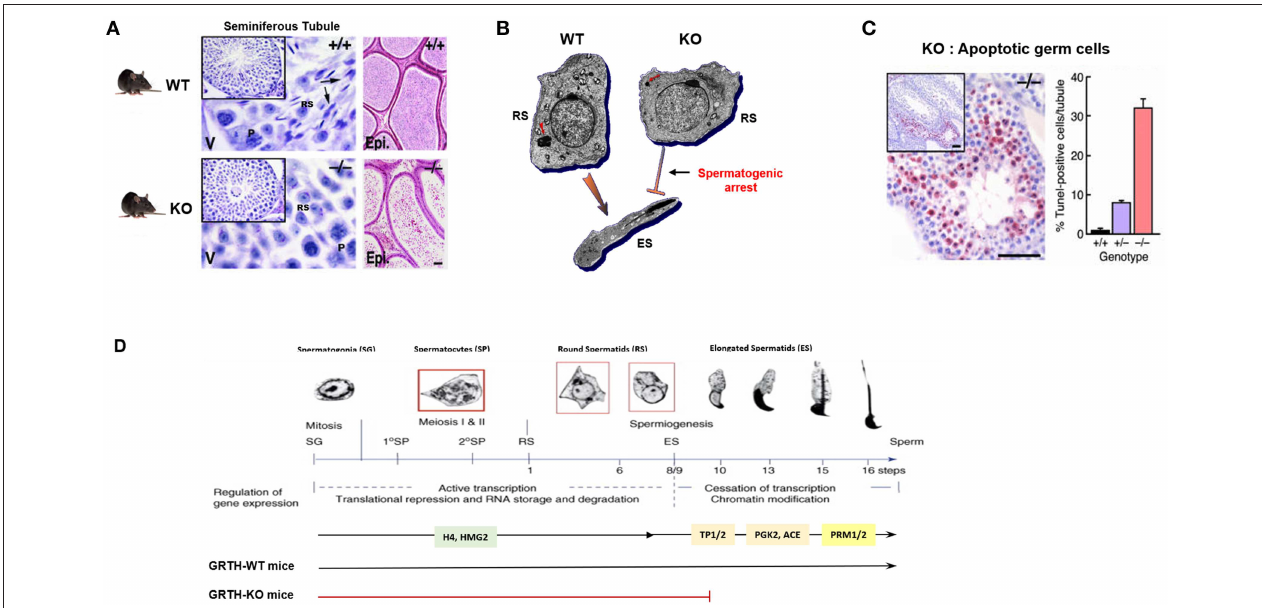
FIGURE 3 | GRTH-KO mice model reveal the role of GRTH in the completion of spermatogenesis. (A) H&E staining of WT and KO mice testis showing seminiferous tubules and epididymis. Presence of elongated spermatids only in WT mice is indicated by arrows. P. pachytene spermatocytes; RS, round spermatocytes. Epididymis lumens of WT mice contains mature sperm while in KO mice lumens are filled with degenerating germ cells ( 23). (B) EM images of round spermatid from WT and GRTH-KO mice and elongated spermatid of WT mice. Absence of GRTH in KO mice causes arrest of spermiogenesis at step 8 of round spermatids and failure to elongate (23). CB of KO mice was highly condensed, greatly reduced in size and lacking the typical nuage texture (red arrow) as compared with wild type CB (red arrow). (C) TUNEL IHC staining of testis section from GRTH-KO mice show marked apoptosis in germ cells compared to WT mice. Quantitative evaluation of apoptosis (right), mean ± SE of apoptotic cells per tubule [10 tubules were assessed for each group (23)]. (D) Diagram of mice spermatogenesis showing spermatogonia (SG, 2n) followed by first meiotic (I) division resulting in the formation of primary (1 ◦ ) and secondary spermatocytes (SP). Secondary SP through meiosis generate haploid round spermatids (RS) entering the differentiation process of spermiogenesis (16 steps in mouse) to produce elongating spermatids (ES) and spermatozoa/mature sperm. Germ cells expressing GRTH (spermatocytes and round spermatids) are boxed in red. The regulation of gene expression during the developmental process is governed in a precise temporal sequence: an initial active transcription phase with translational repression is followed by cessation of transcription associated with chromatin modification. Chromatin structure in spermatogenic cells changes during development from mitotic spermatogonia into meiotic SP and post-meiotic haploid spermatids. During spermatid elongation, histones are removed and replaced by TP1 and TP2 and subsequently by Prm1 and Prm2. GRTH- dependent expression of proteins is highlighted including H4 (testis specified histone), HMG2, TP2/TP1, testicular ACE, PGK2, Prm1/Prm2. RS development in the WT showing progression to mature sperm. In GRTH-KO, there is a spermatogenic arrest observed at step 8 of RS (